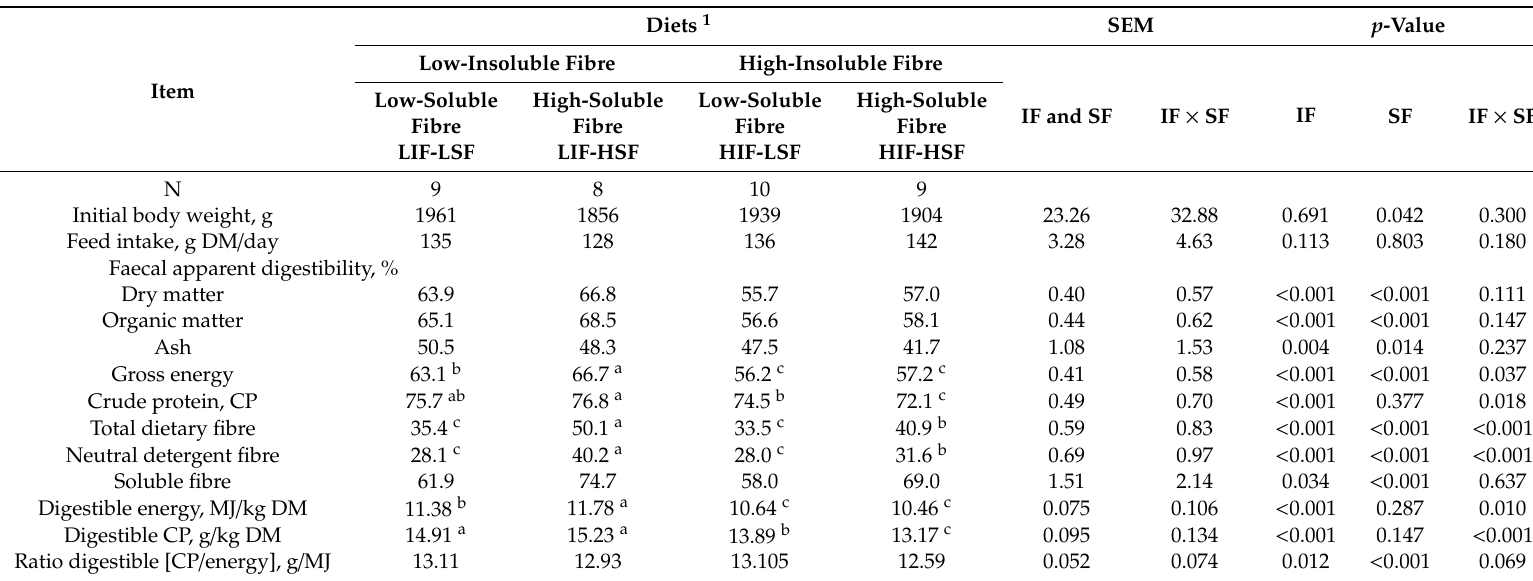
Table 3. E ff ect of dietary level of insoluble and soluble fibre on faecal apparent digestibility of dietary components in rabbits from 54 to 57 days of